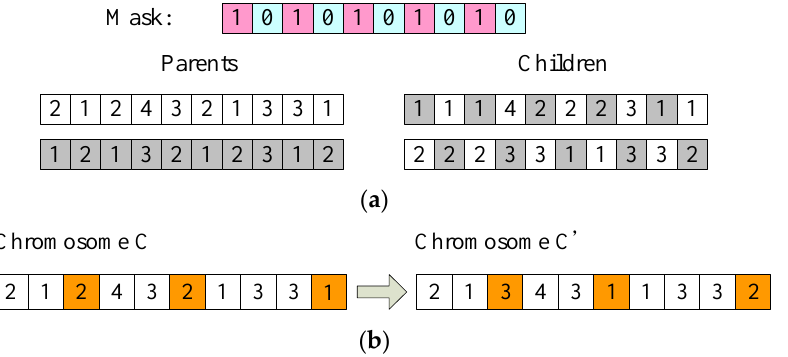
Algorithm 3: Discrete PSO with GA operators (DPSO_GA) Algorithm